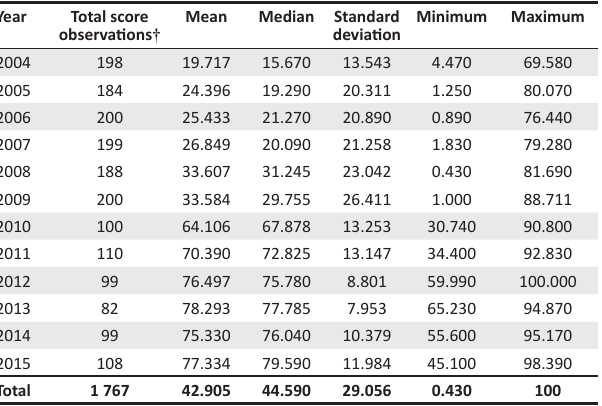
TABLE 5: Descriptive statistics for the total Broad-Based Black Economic Empowerment score.